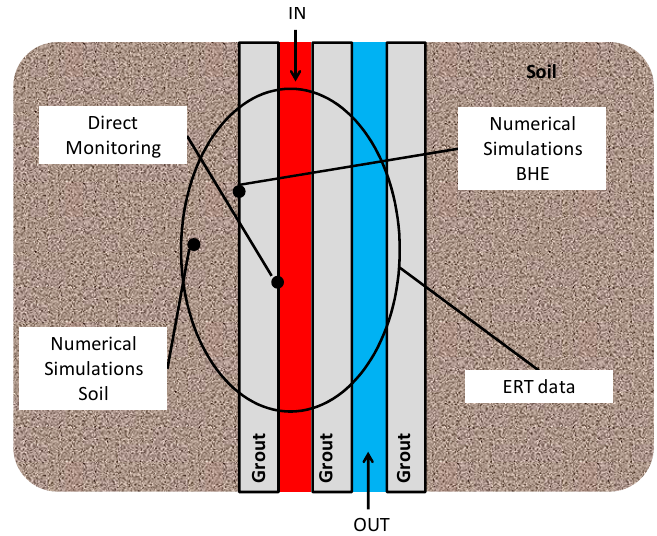
Figure 9. Scheme of a BHE with the position of the different monitoring points depicted in Figures 7, 8 and 10.